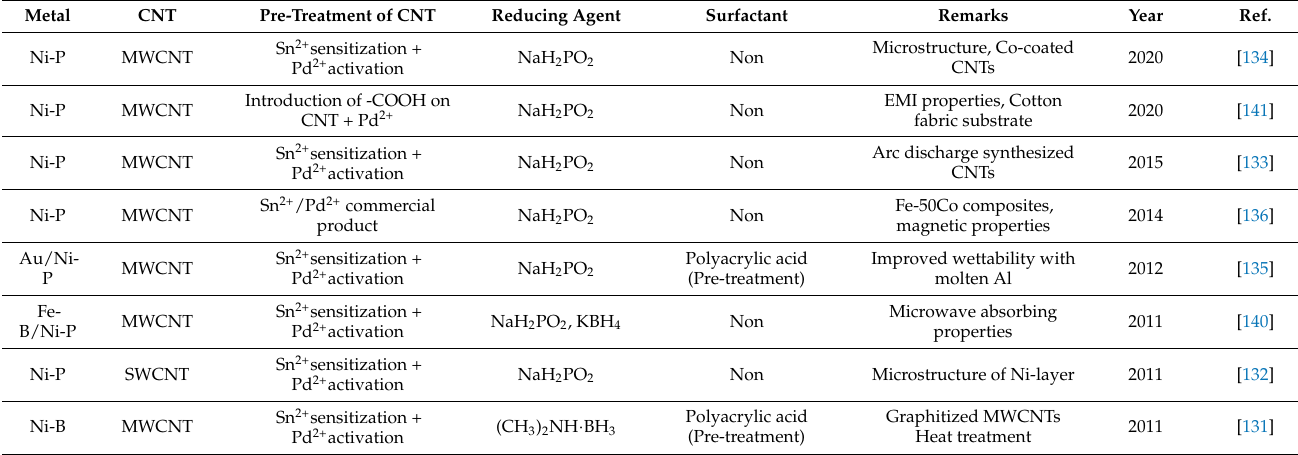
Table 3. Fabrication conditions of metal-coated CNTs by electroless